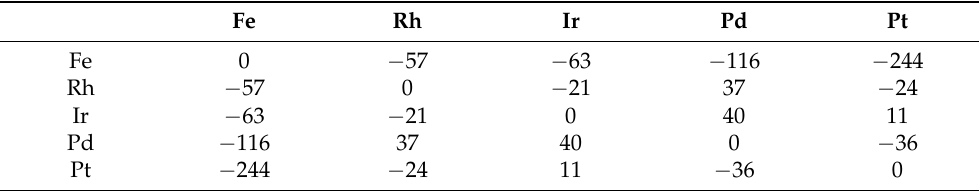
Table 4. Enthalpies of each binary compound. The unit is meV/atom. Data from